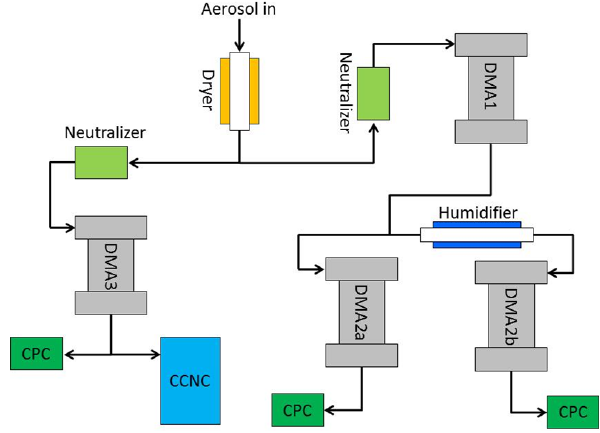
Figure 2. Schematic illustration of the experimental set-up for the dual H-TDMA and CCN